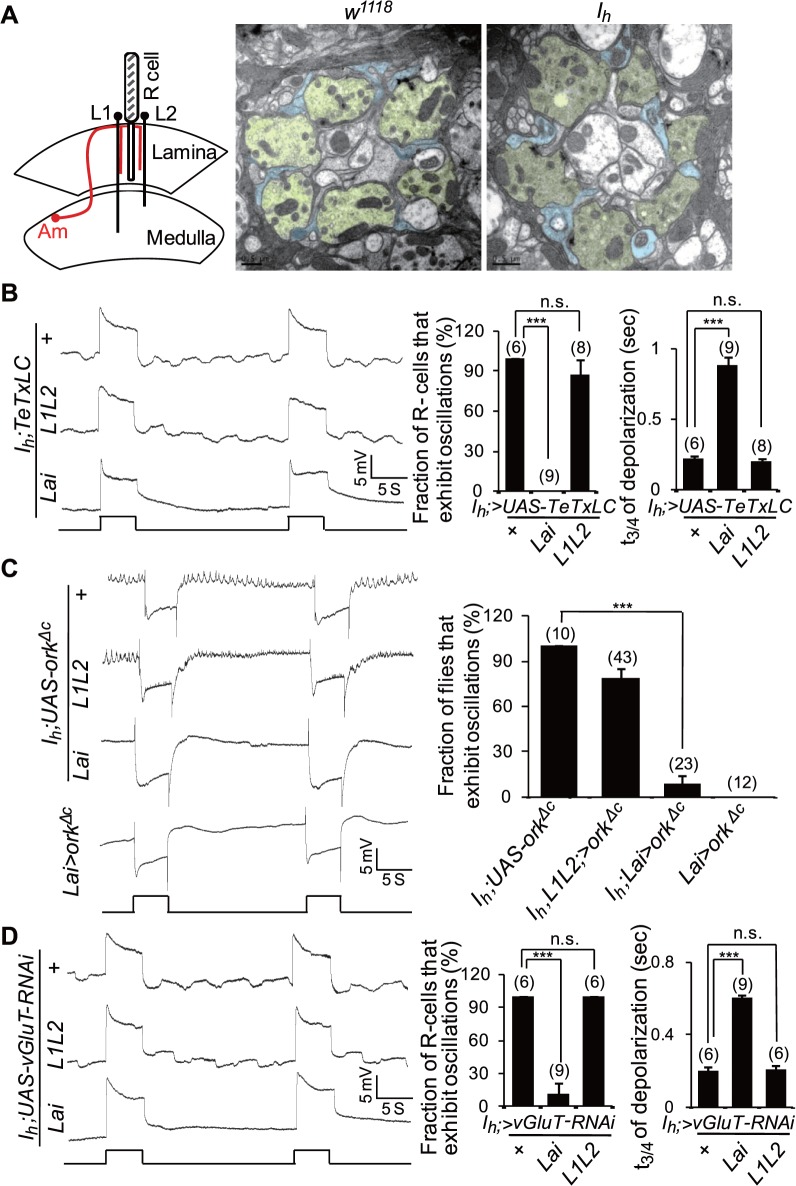
Blocking synaptic glutamate release from ACs suppresses the rhythmic depolarization in I
h mutant photoreceptors.(A) Ultrastructure of lamina cross-sections in wild-type and I
h mutant flies. The left panel shows the organization of the columnar neurons with synaptic connections in the lamina. Photoreceptor cells are shown in gray, L1–L2 neurons in black, and ACs in red. These neurons are present in all lamina columns, and single example profiles are shown arrayed across the lamina. The middle and the right panels show EM images of lamina cross-sections in wild-type and I
h mutant flies, respectively. Photoreceptor axons are colored in yellow and AC processes in blue. (B) Intracellular recording traces of I
h mutant flies with expression of TeTxLC using L1L2-GAL4 and Lai-GAL4 drivers. The fractions of photoreceptors that exhibit rhythmic depolarization are presented in the middle panel, and the time (t3/4) required for a 3/4 recovery from the responses upon stimulation cessation is shown in the right panel. The numbers of recorded flies are listed. (C) Inactivation of ACs via ectopic expression of dORKΔC suppresses rhythmical depolarization in I
h mutant flies. The fractions of flies that exhibit ERG oscillation phenotype and the numbers of recorded flies are presented in the right panel. An ERG trace of flies expressing dORKΔC in wild-type ACs is also presented. (D) Intracellular recording traces of I
h mutant flies expressing UAS-vGluT-RNAi using different drivers. The fractions of photoreceptors that exhibit rhythmical depolarization are presented in the middle panel, and the time (t3/4) required for a 3/4 recovery from the responses upon stimulation cessation are shown in the right panel. The number of recorded flies for each genotype is listed.